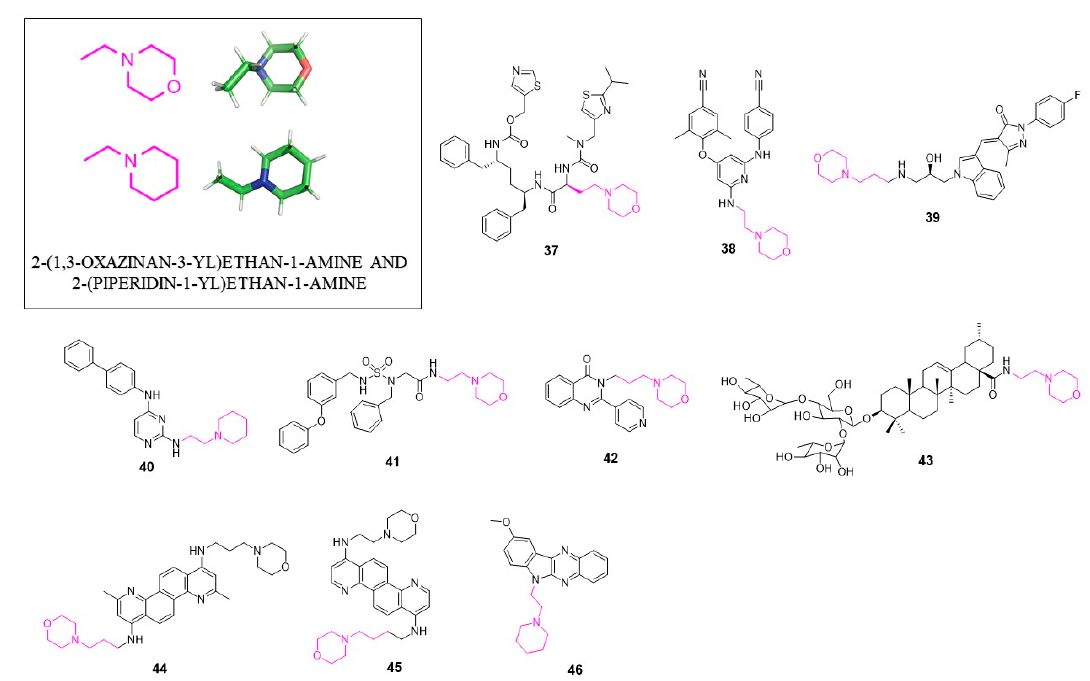
Figure 4. Antivirals with 2-(1,3-oxazinan-3-yl)ethan-1-amine and 2-(piperidin-1-yl)ethan-1-amine. Compounds with 2-(1,3-oxazinan-3-yl)ethan-1-amine moiety were found to be useful